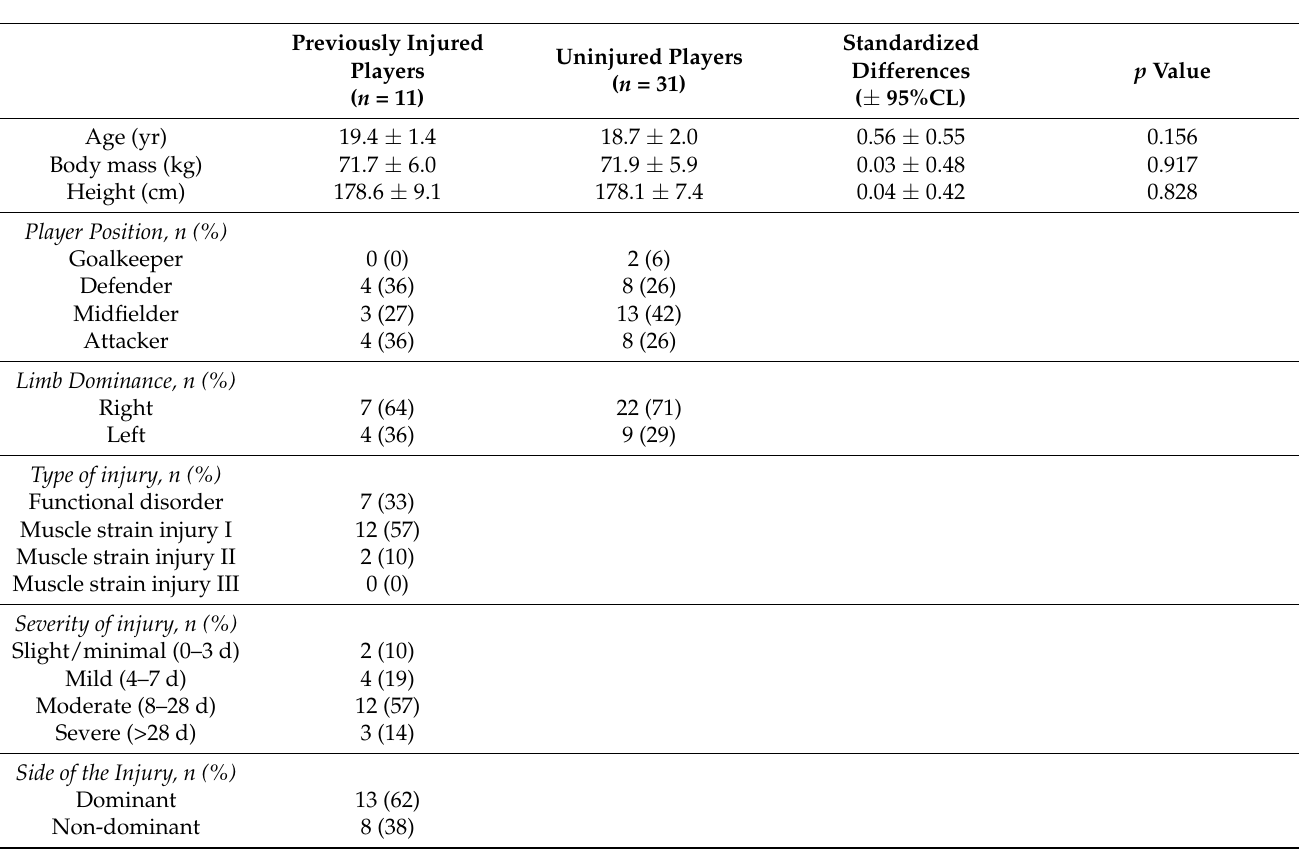
Table 1. Characteristics and information regarding the prior hamstring injuries of the subjects participating in this